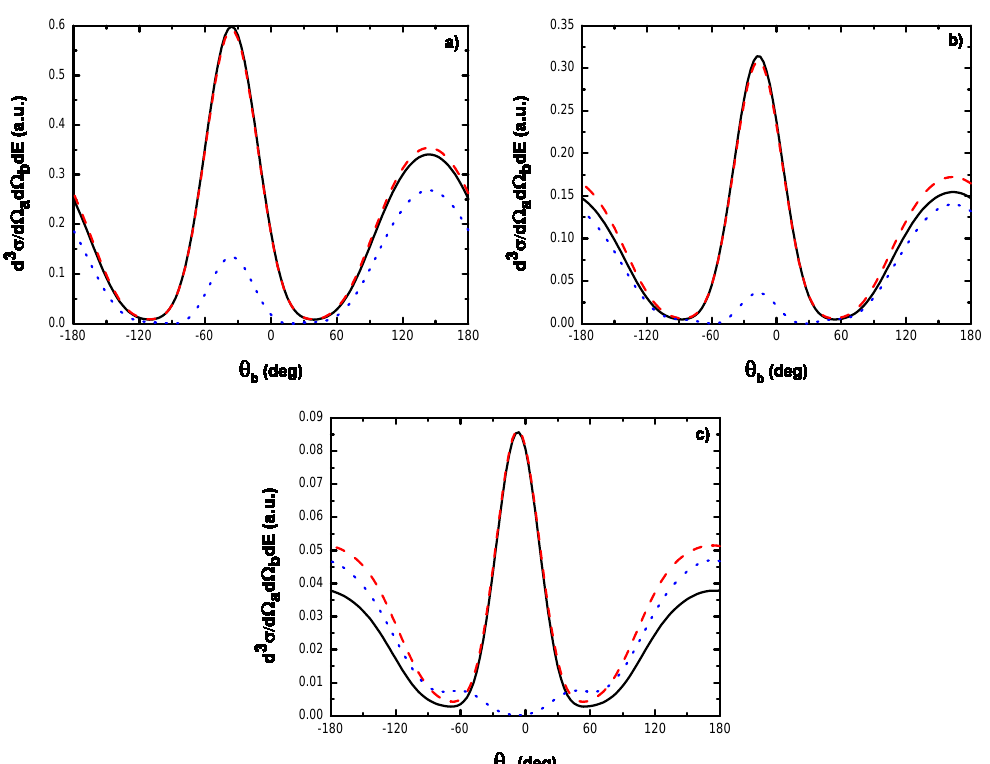
Figure 9. The same as in Figure 6, but the laser polarization vector is parallel to the momentum transfer ( ˆ ε // ∆ )